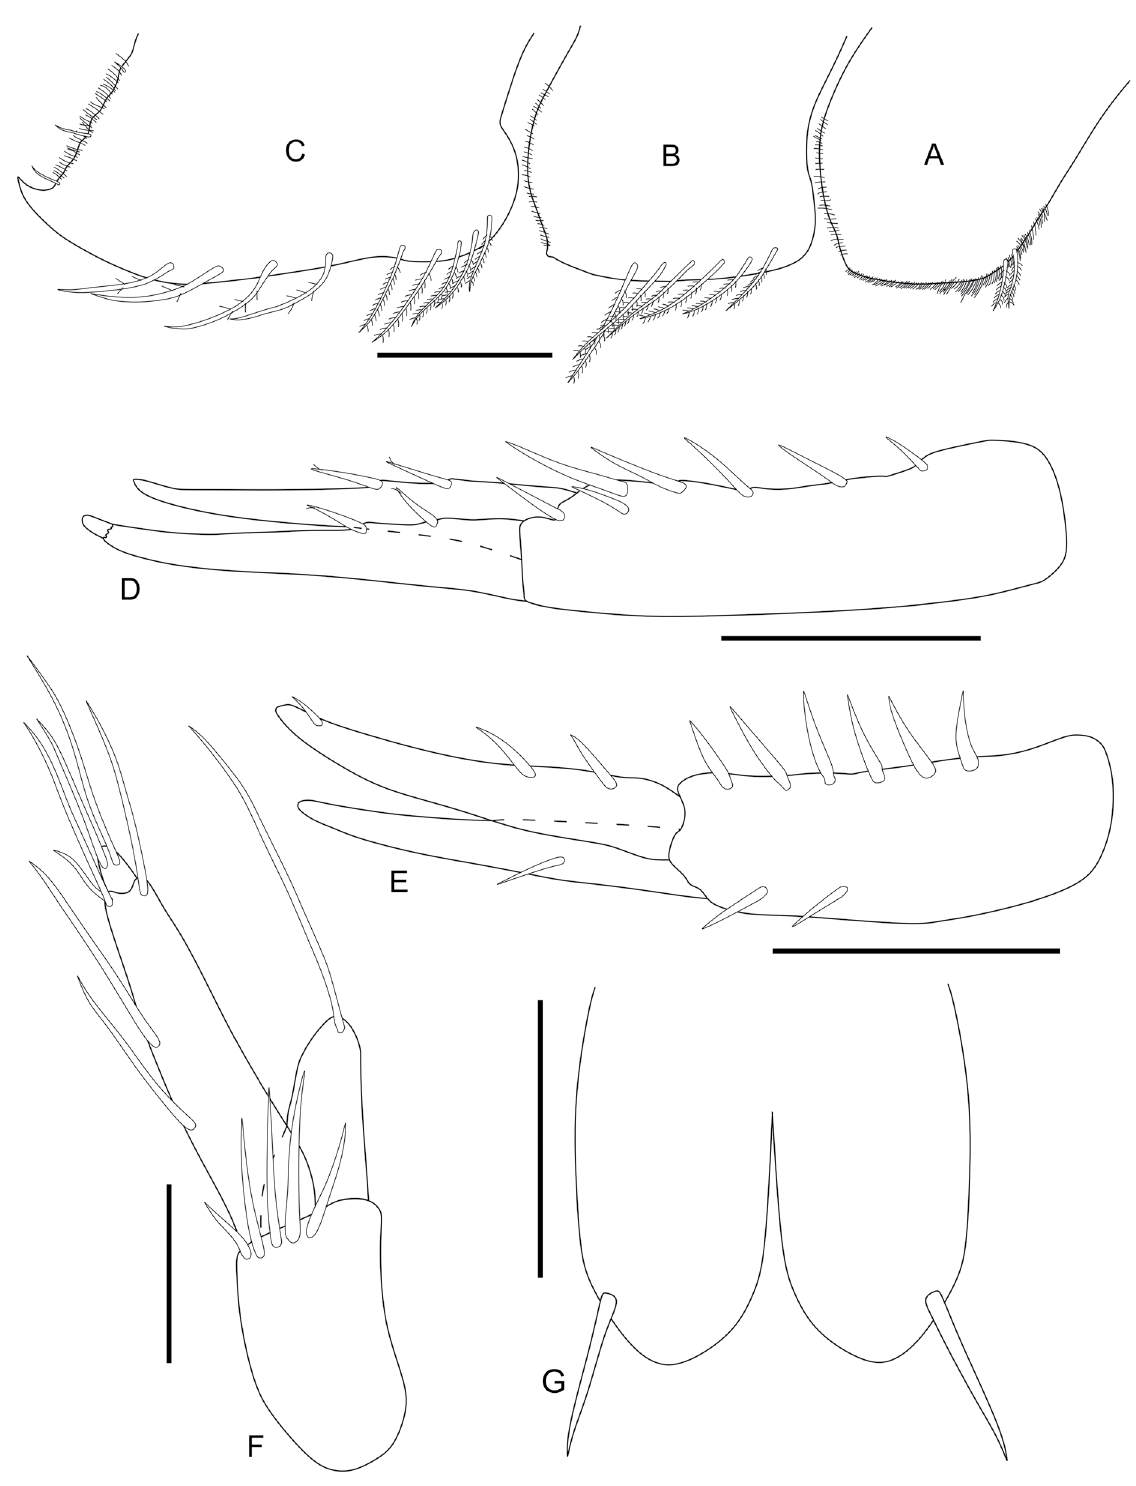
Fig. 5. Heterophoxus shoemakeri sp. nov., holotype, ♀ (UERJ 433). A . Epimeral plate 1. B . Epimeral plate 2. C . Epimeral plate 3. D . Uropod 1 E . Uropod 2. F . Uropod 3. G . Telson. Scale bars: A–E, G = 0.2 mm; F = 0.1